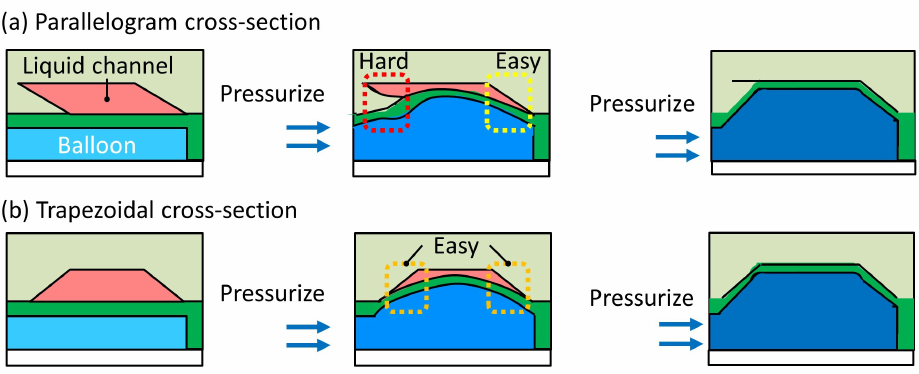
Figure 2. Cross-sections of microchannels of pneumatic pressure-driven microvalves. ( a ) Parallelogram- shaped cross-section; ( b ) trapezoid-shaped